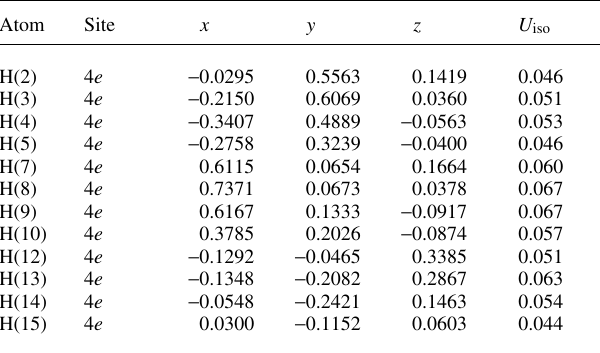
Table 2. Atomic coordinates and displacement parameters (in Å 2 ) . Table 1. Data collection and